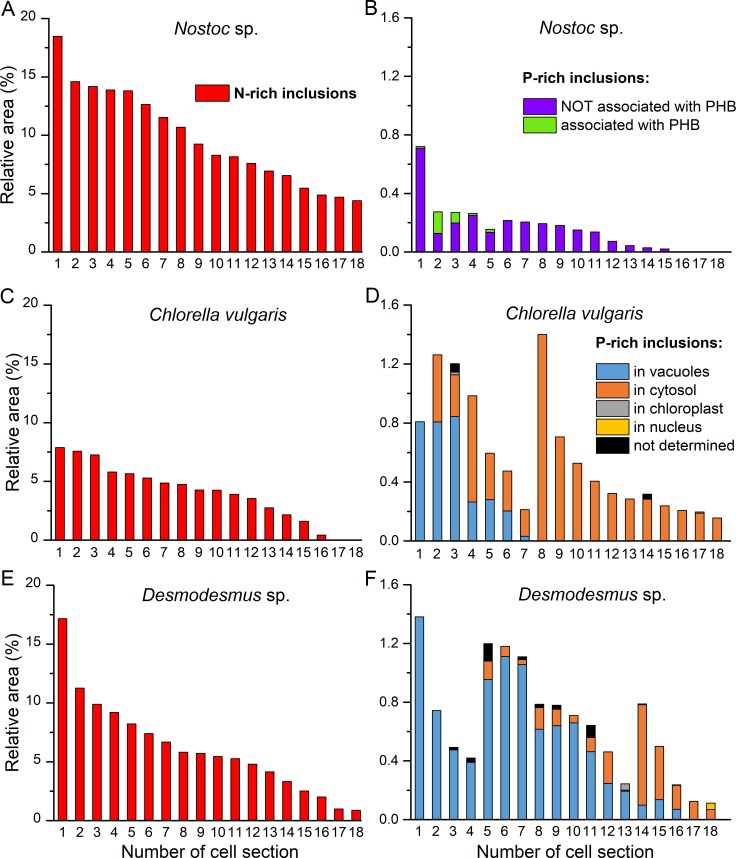
Estimation of the N and P reserve abundance in the studied cells.(A) and (B) Estimation of the reserves in the Nostoc sp. PCC 7118 cells. (C) and (D) estimation of the reserves in the Chlorella vulgaris IPPAS C-1 cells. (E) and (F) estimation of the reserves in the Desmodesmus sp. IPPAS S-2014 cells. (A), (C) and (E) estimation of the N reserves in the cells of P-starved cultures. (B), (D) and (F) estimation of the P reserves in P-sufficient cells sampled from the stationary phase cultures. The results expressed in relative area of the P-rich or N-rich inclusions are shown for each cell section (n = 18). Relative area values on the histograms are sorted in descending order (A), (C), (E) or in descending order within the following groups: in (B), both P reserves associated with PHB and P reserves not associated with PHB; only P reserves not associated with PHB; in (D) and (F), main P reserves in the vacuoles, no P reserves in the cytosol; P reserves both in the vacuoles and in the cytosol and the main P reserves are located in the vacuoles; P reserves both in the vacuoles and in the cytosol and the main P reserves are located in the cytosol; the main P reserves in the cytosol, no P reserves in the vacuoles. For the P-rich inclusions (B), (D), (F) subcellular localization is also shown.